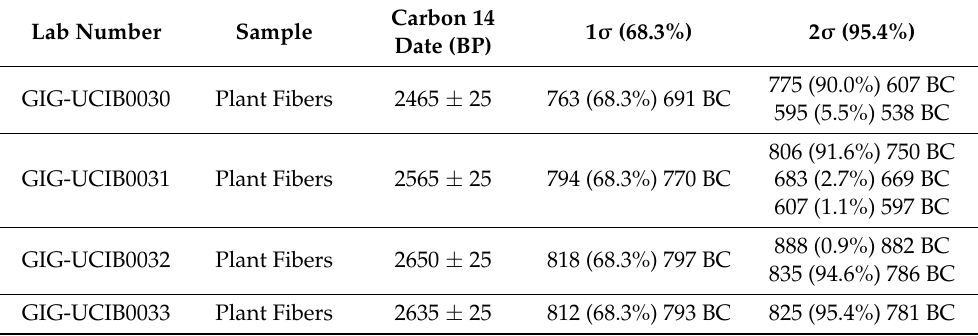
Table 1. Calibrated radiocarbon dates from the second layer of sediments at the bottom of Panlong Lake. All of the dates were provided by the 14 C Accelerator Mass Spectrometry Laboratory of the